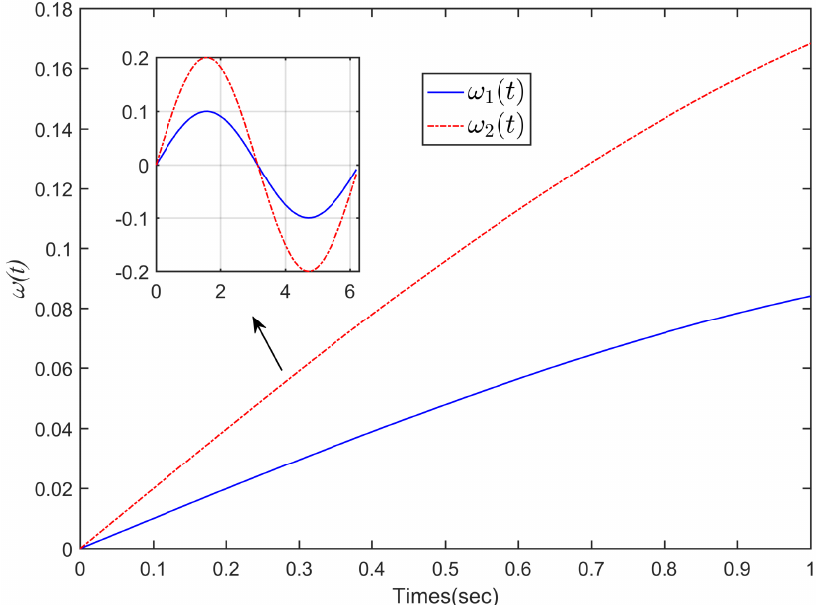
Figure 2. External disturbance ω ( t )